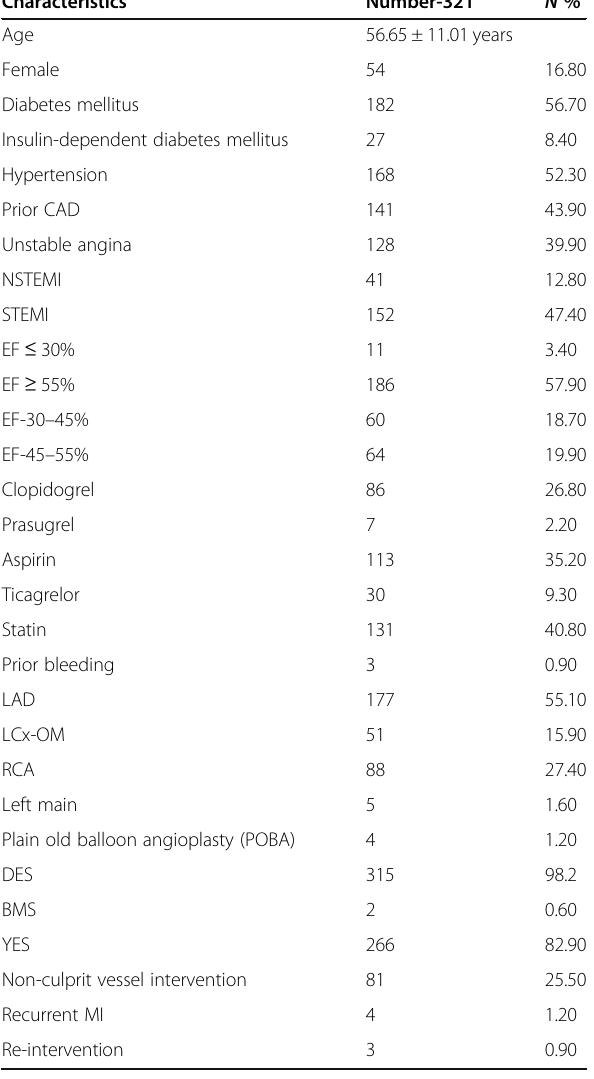
Table 1 Baseline characteristic of patient